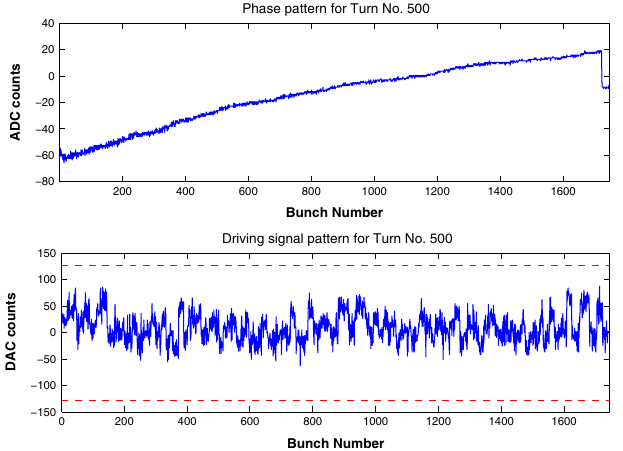
FIG. 8. (Color) Time-domain fault file from the HER showing the data at the output of the DSP filters (the output signals from the DSP baseband processing with dynamic range þ 127 = (cid:2) 128 DAC counts) The transient content is significant enough to pass through the control filter and saturate the power stage near 1000 turns in the data set. The 5000 turns of the recording is 36 ms long and is from an 1800 mA HER fill.